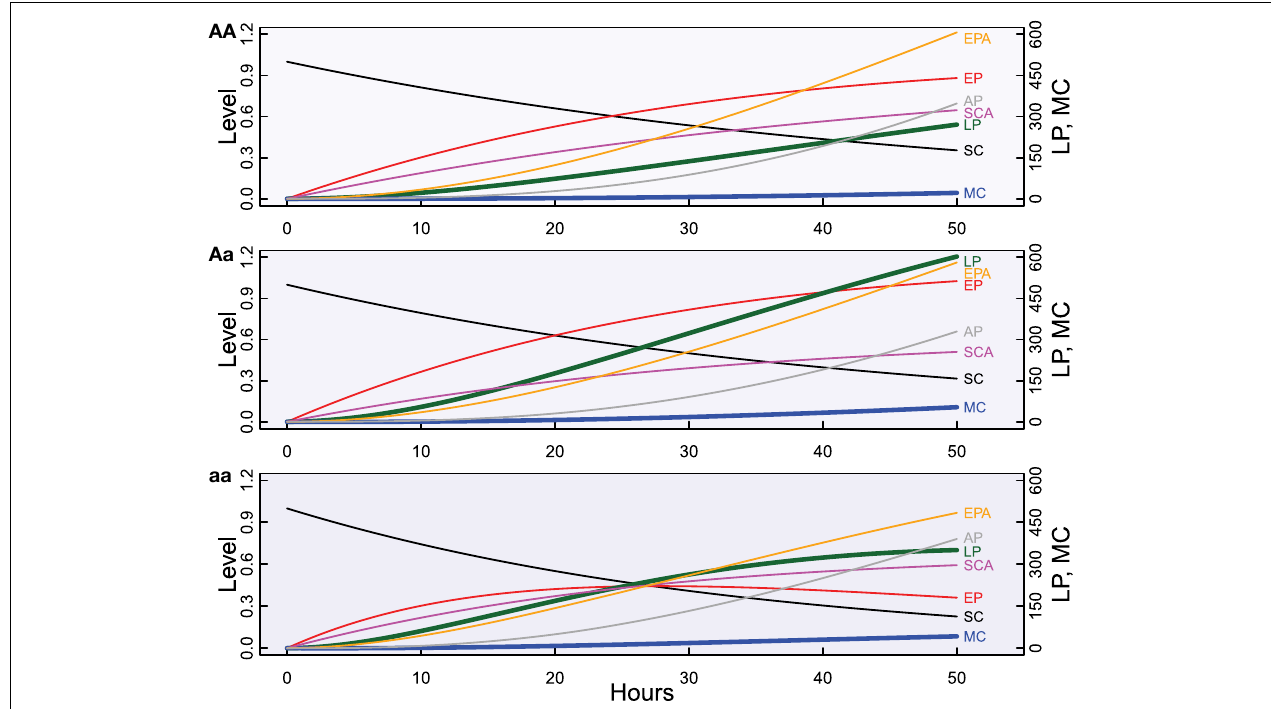
FIGURE 2 | Genetic differences in the dynamic behavior of a cancer stem cell-initiating system composed of seven biological aspects (SC, EP, LP, MC, SCA, EPA, andAP) of cell proliferation characterized by ODEs (1) at a gene having genotypes AA , Aa , and aa